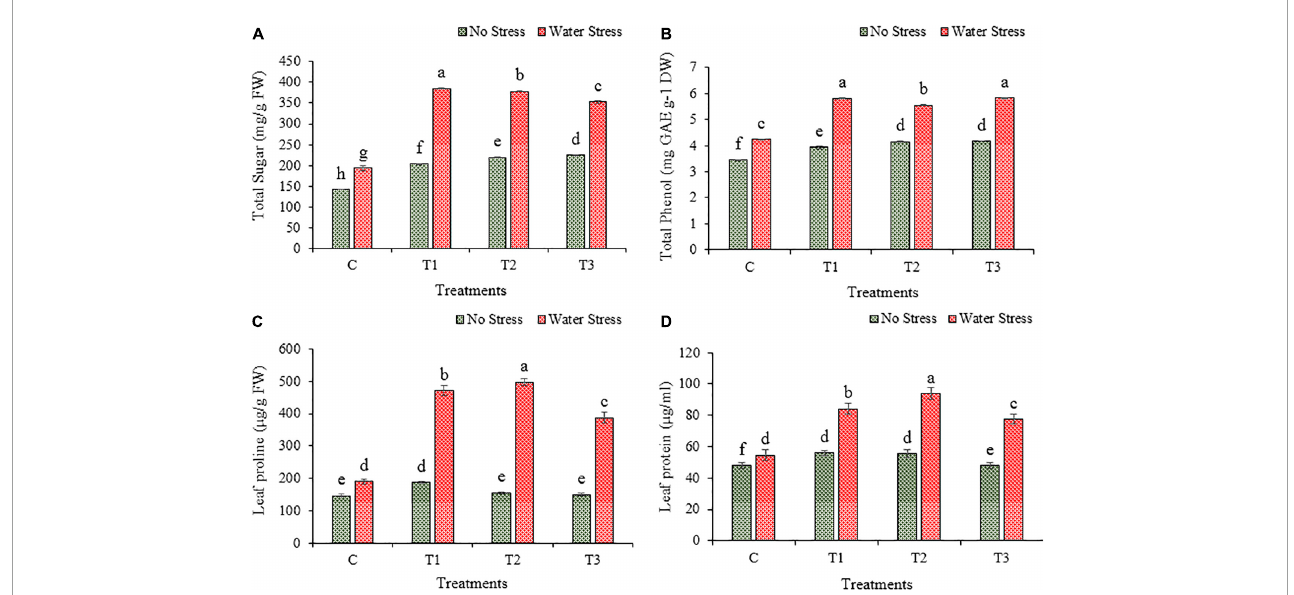
FIGURE9 Impacts of bacterial treatments (T1- Enterobacter cloacae BHUAS1) (T2- Bacillus megaterium BHUIESDAS3) ( Bacillus cereus BHUAS2) on various features of wheat plants under the influence of water induced drought stress (A) total sugar, (B) total phenol, (C) proline content, and (D) protein content. The different alphabets indicate statistically significant differences between each treatment (DMRT p < 0.05).